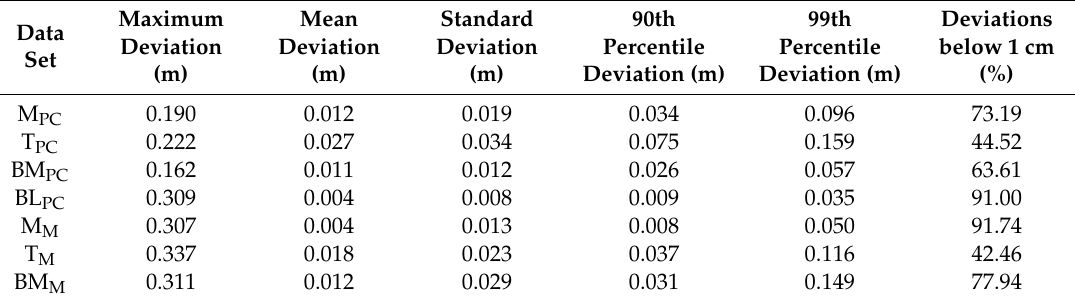
Table 6. Results of the distance analysis of the Tetra segment.